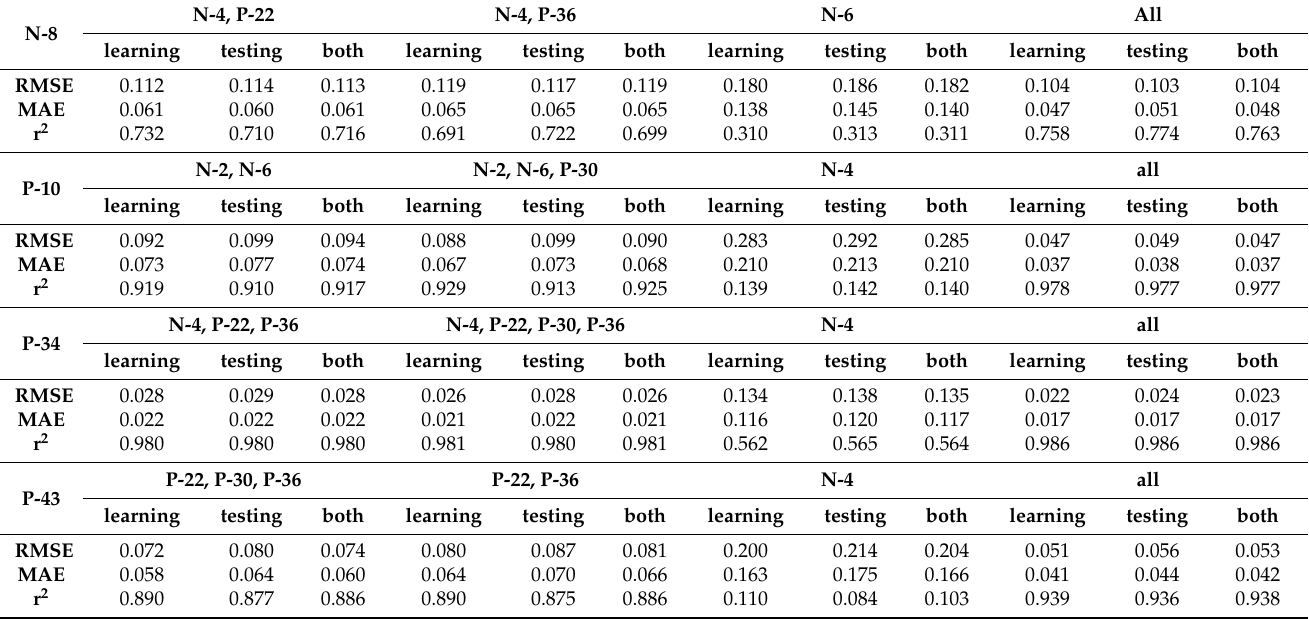
Table 2. Support vector regression (SVR) modelling